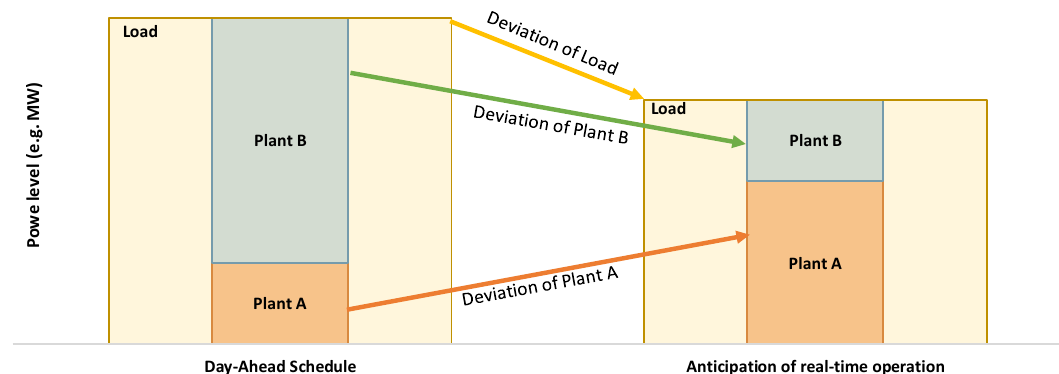
Figure 3. Example of resources, which are eligible for adjusting their schedule in the intra-day market (Plant B) and those which are not eligible to adjust (Plant A).